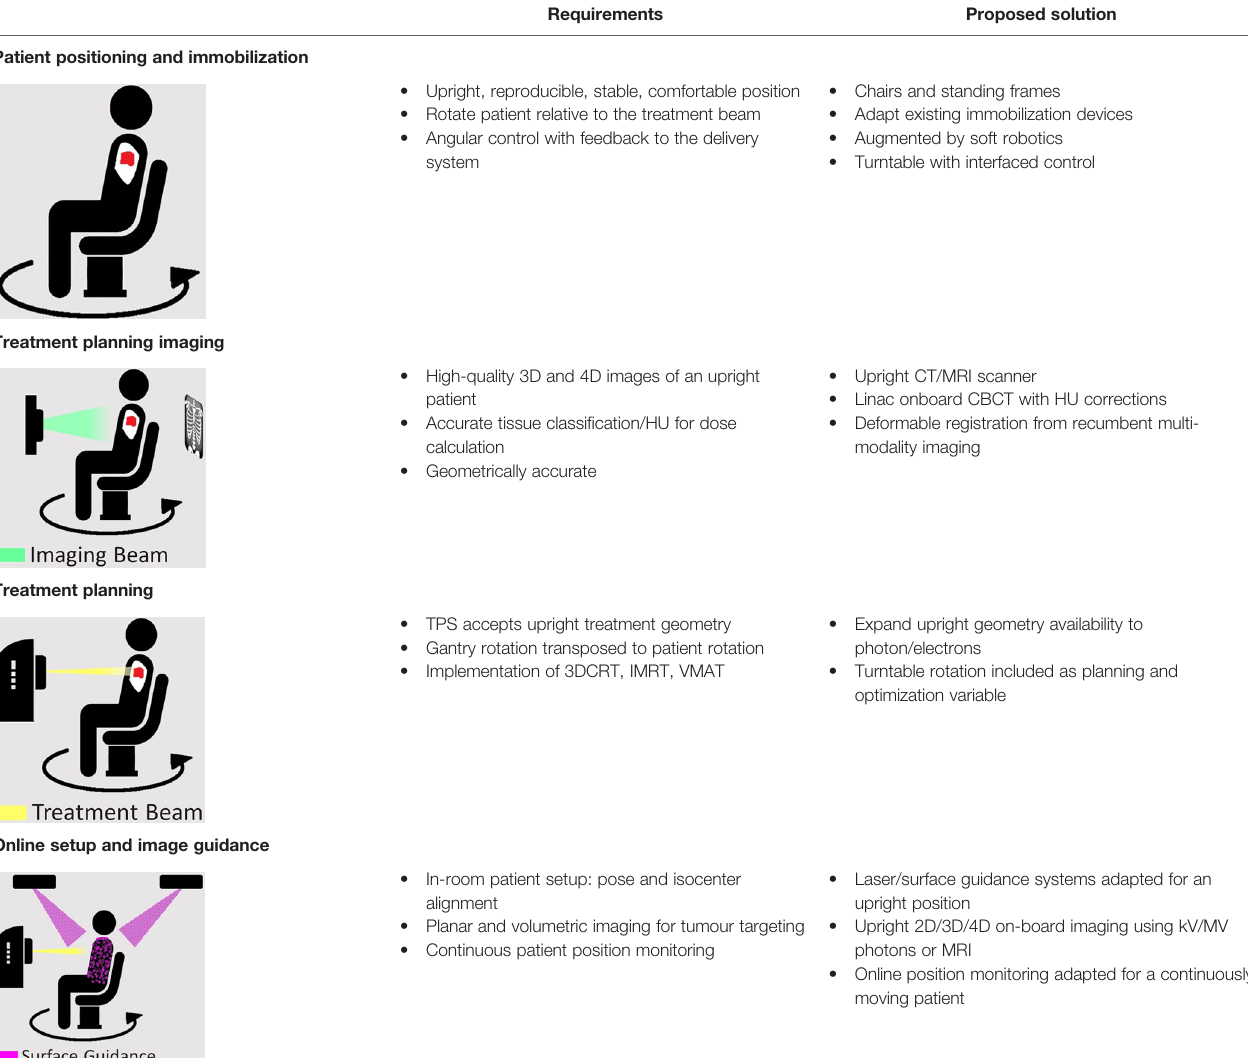
TABLE 1 | Overview of the key requirements that need to be met for clinical upright radiation therapy, and the proposed solutions that are detailed in this paper. This includes patient position and immobilization, treatment planning imaging, treatment planning, and online setup and image guidance. Requirements Proposed solution Patient positioning and